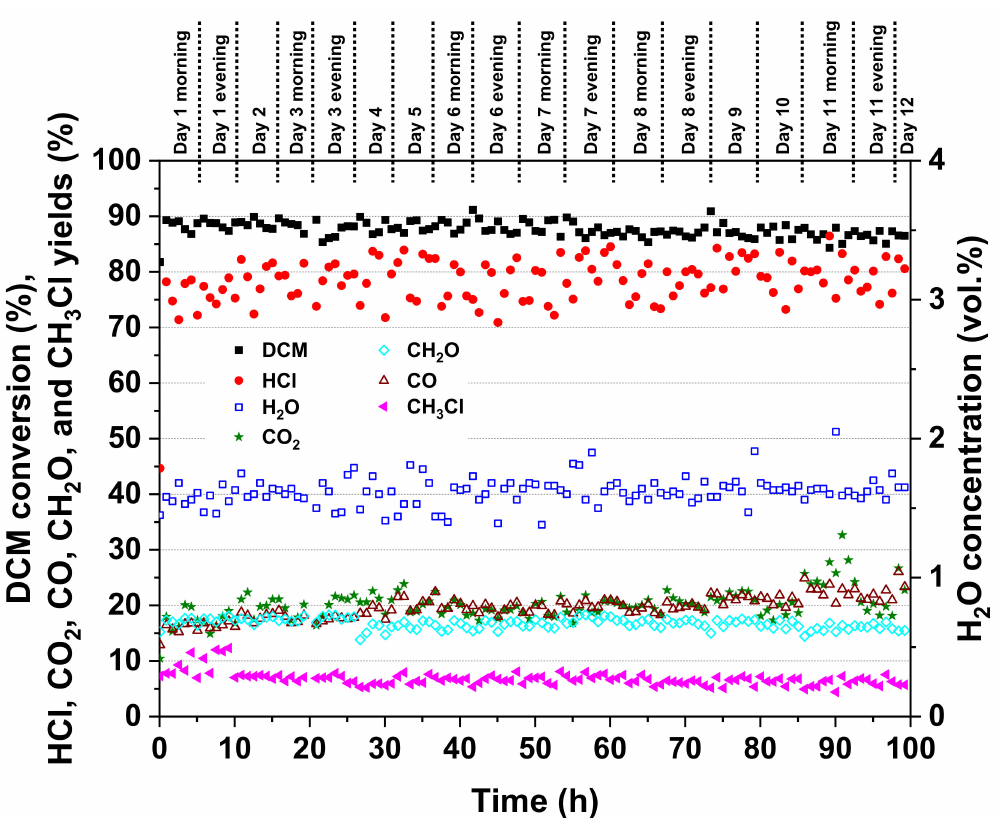
Figure9. StabilityofthePt-Au / AlcatalystinDCMoxidationduringthe100-htest(395 ◦ C,DCM500ppm,